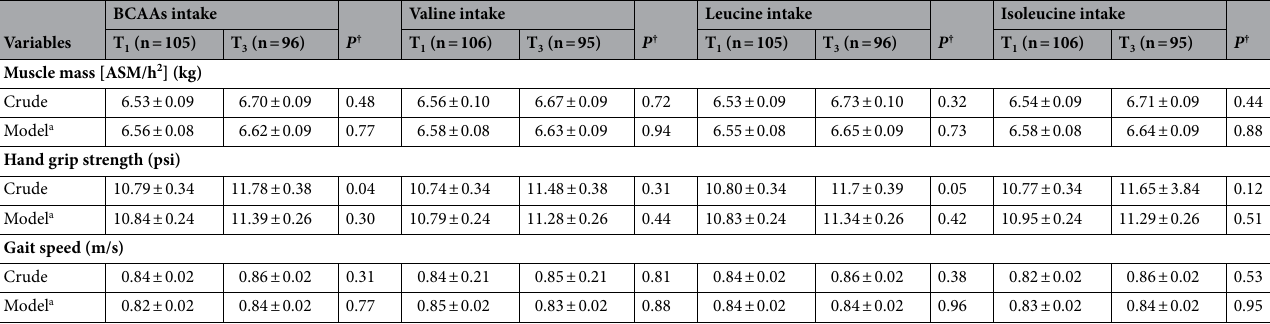
Table 5. Crude and adjusted means of components of sarcopenia across tertiles of total and individual BCAAs intake. Obtained from ANOVA (P < 0.05 significant). Model a : Adjusted for energy, age and